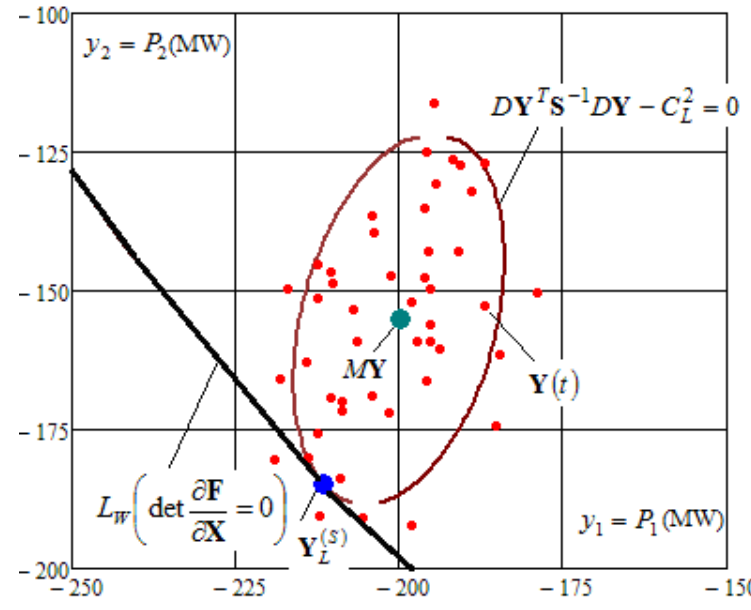
Figure 8. Increased risk of stability loss with a disabled ETL 2–3 ( R SAS = 29%). Using Table 1, we drew graphs for